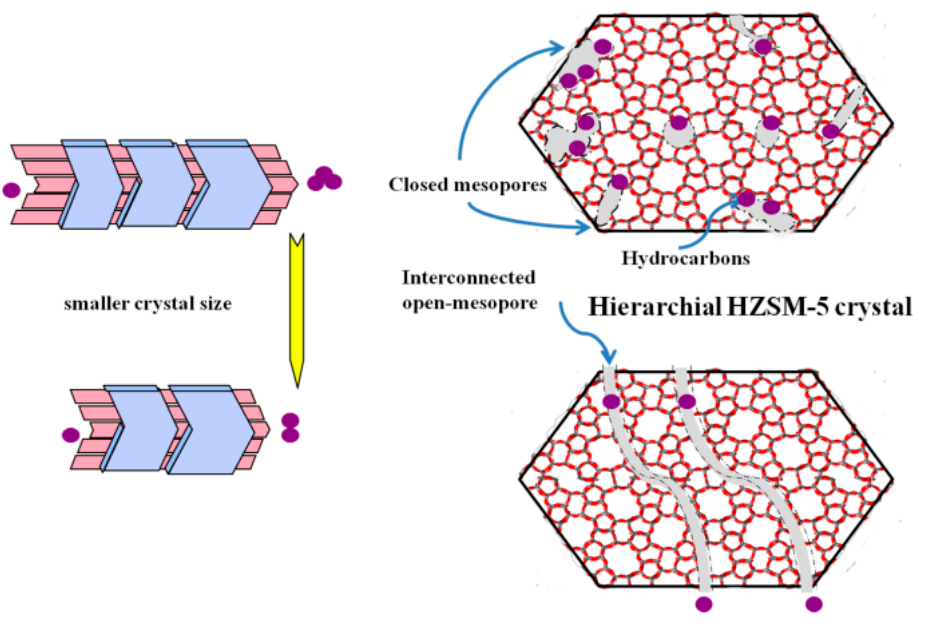
9 of 14 Figure 7. Thermogravimetric curves of spent catalysts after 12 h in oligomerization. 2.4. Schematic Illustration of the Improved Diffusion To better understand the main mechanism of improved diffusion, it is schematically demonstrated in Scheme 1. Diffusion limitation within microporous zeolites is a severe problem because of fast deactivation. Above all, the CsOH-treated HZSM-5 catalyst was more resistant